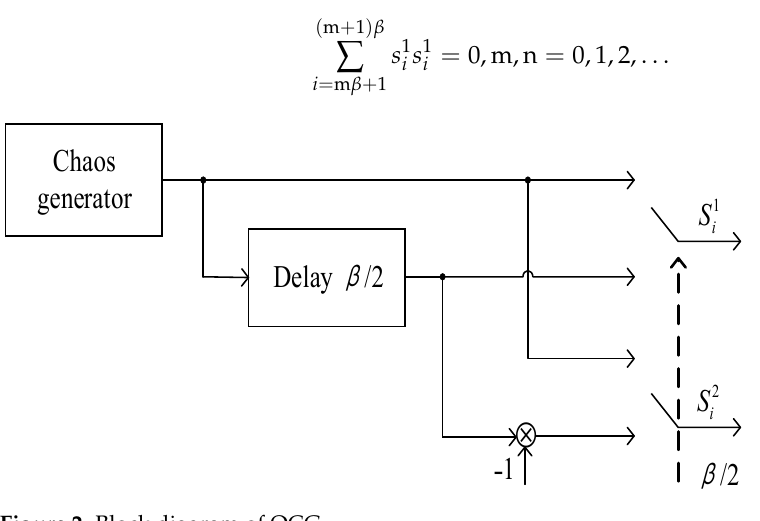
Figure 2. Block diagram of OCG.